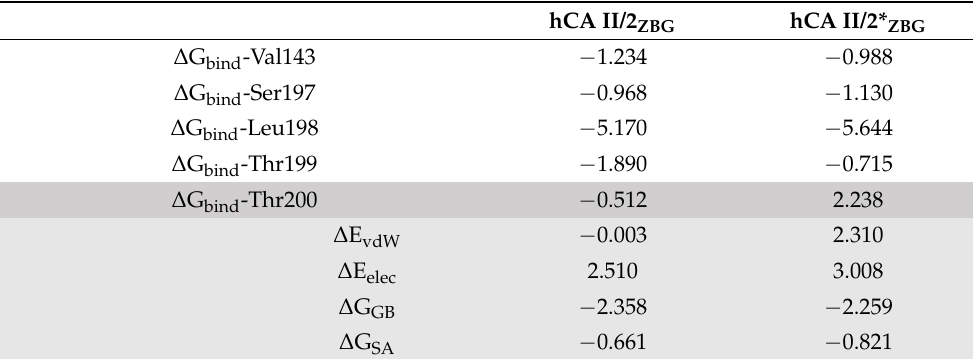
Table 2. Per-residue decomposition of the binding free energy (kcal/mol) computed by the MM/GBSA method for the model complexes hCA II/ 2 ZBG and hCA II/ 2* ZBG . Details of the ∆ G bind -Thr200 energy terms (kcal/mol) are shown in light grey lines. ∆ G bind -Val143 ∆ G bind -Ser197 ∆ G bind -Leu198 ∆ G bind -Thr199 ∆ G bind -Thr200